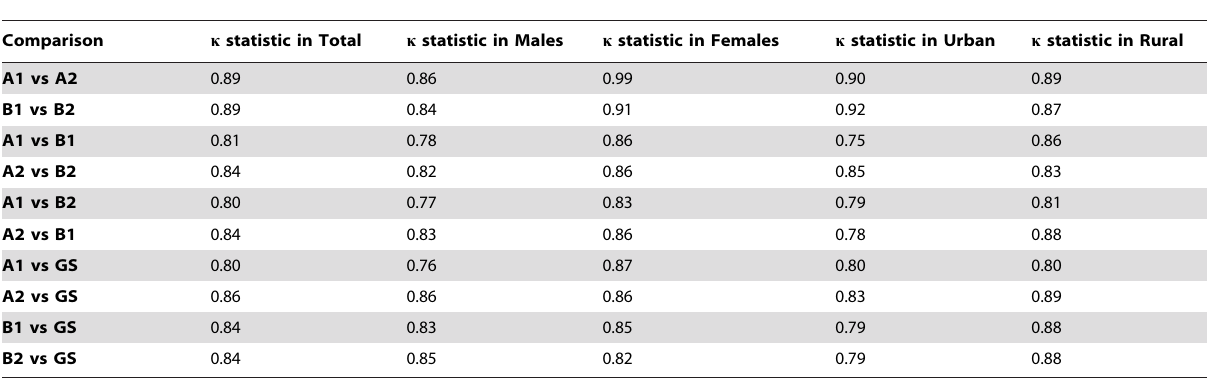
Table 4. Kappa statistics for reliability and validity testing of VA interview in 219 deaths.